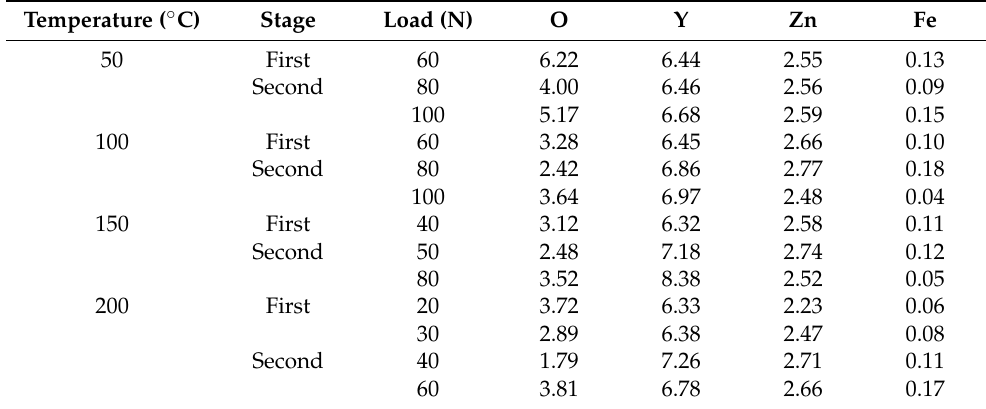
Table 3. Contents of major elements on the worn